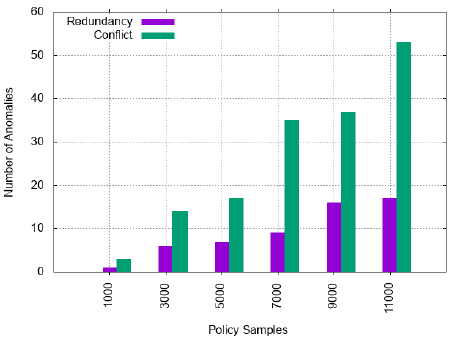
Figure 2. The number of anomalies in the generated policies have applied our method to several examples of impor- tant sizes. We construct a set of ABAC policies (syn- thetic datasets), composed of the combination of eight subject attributes, four resource attributes and